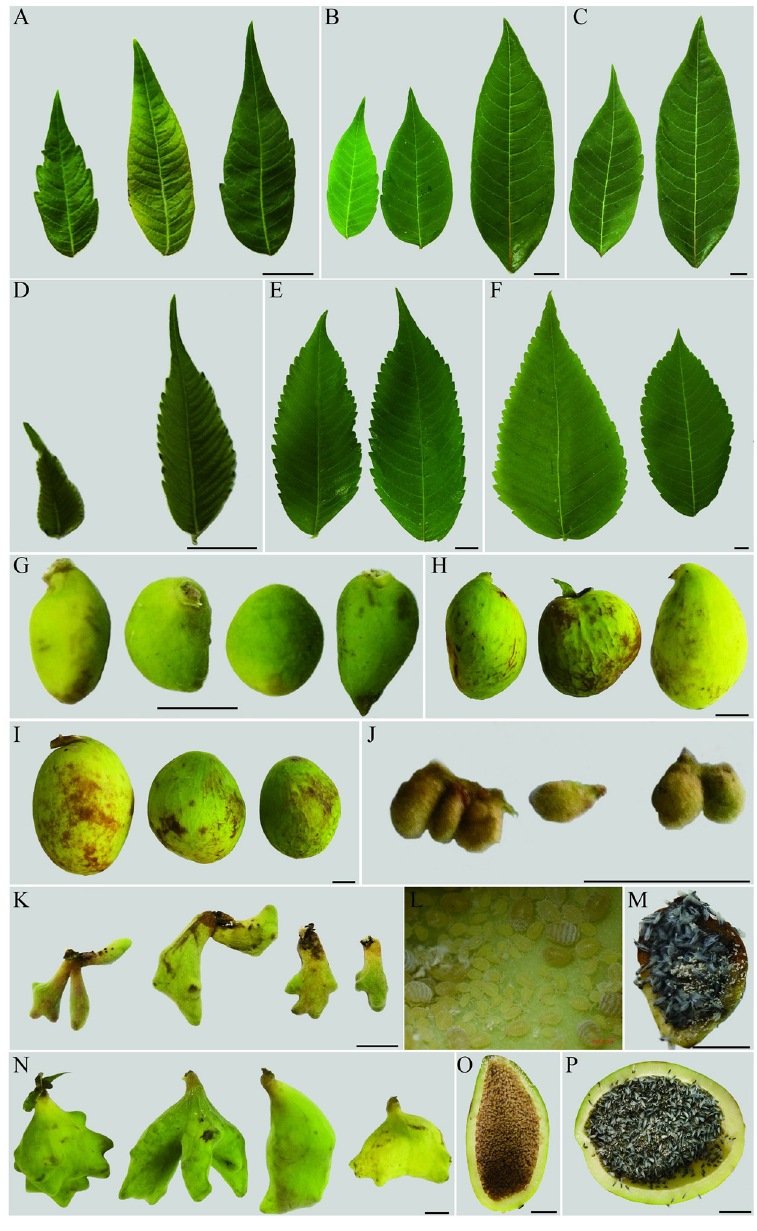
Fig 1. Morphology of R . potaninii and R . chinensis leaflets, horned and fusiform galls at different stages. (A) R . potaninii leaflets at initial stage. (B) The R . potaninii leaflets at third stage. (C) R . potaninii leaflets at fifth stage. (D) R . chinensis leaflets at initial stage. (E) R . chinensis leaflets at third stage. (F) R . chinensis leaflets at fifth stage. (G) Fusiform galls at initial stage. (H) Fusiform galls at third stage. (I) Fusiform galls at fifth stage. (J) Horned galls at initial stage. (K) Horned galls at third stage. (L) S . chinensis within horned gall at third stage. (M) S . chinensis within horned gall at fifth stage. (N) Horned galls at fifth stage. (O) K . rhusicola within fusiform gall at third stage. (P) K . rhusicola within fusiform gall at fifth stage. (A–K, M-P) scale bars = 1 cm; (L) scale bar = 200 μ m. fastest from 21 to 31 May, and the galls grew in weight and volume by eight times. A similar growth rate was observed in R . potaninii leaflets, but on a larger scale. The developmental peak occurred from 5 to 12 June, and the weight and volume increased by approximately 18 times (Fig 2K and 2L). In general, during the rapid growth stage (21 May to 30 June for fusiform